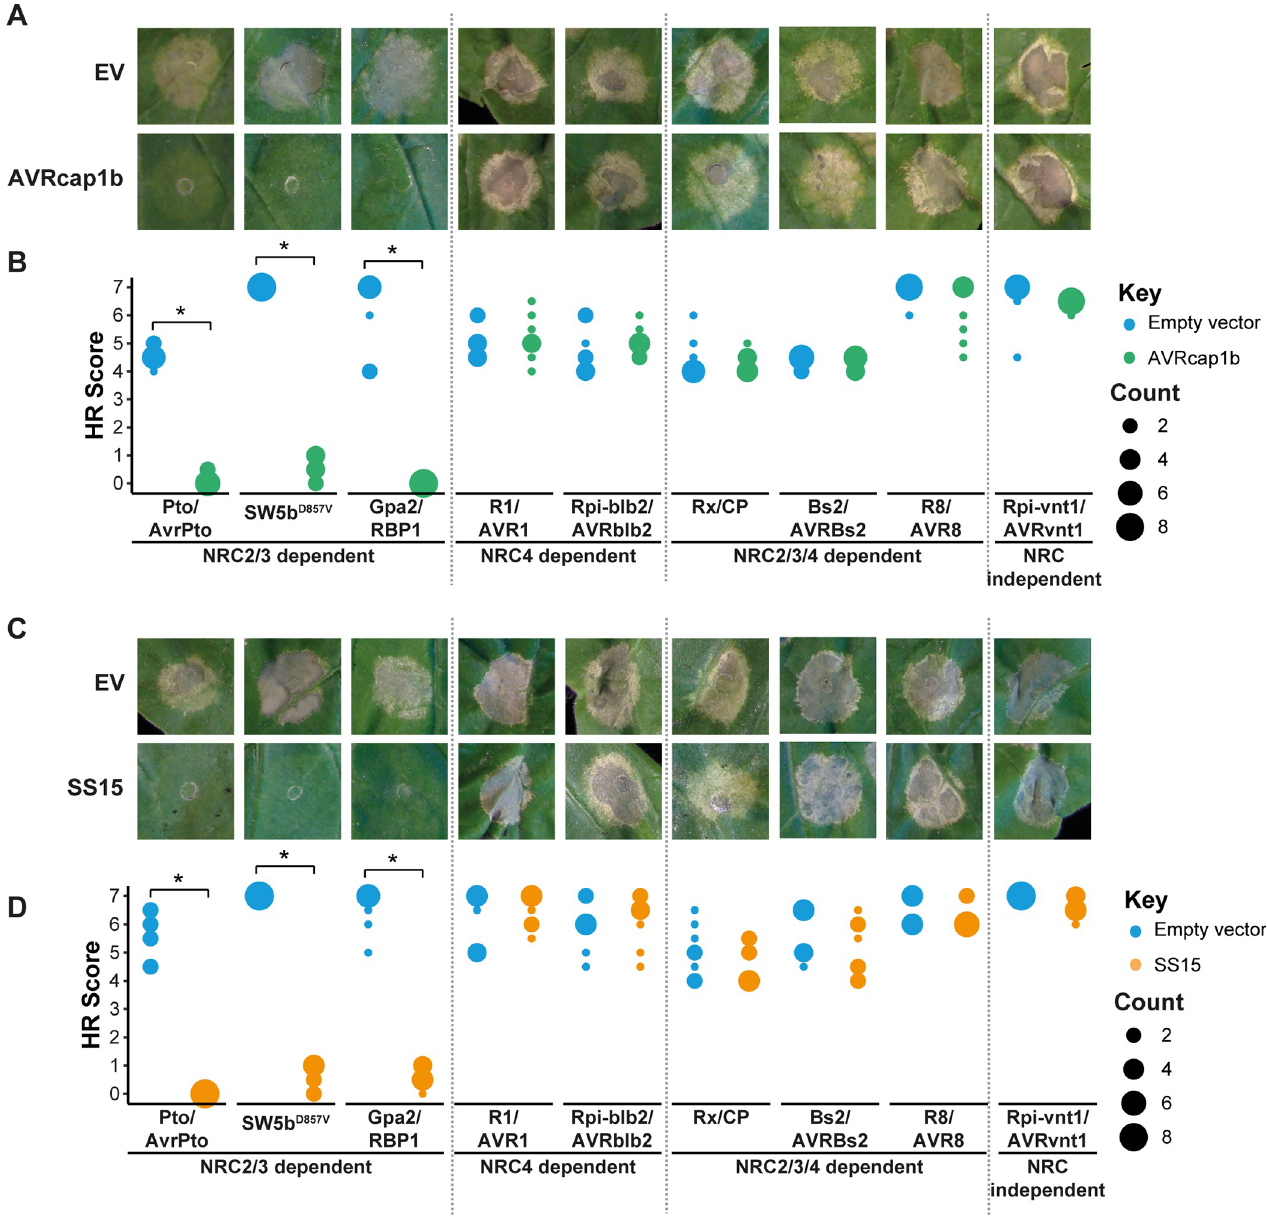
Fig 3. AVRcap1b and SS15 suppress cell death mediated by sensor NLRs that signal through NRC2 and NRC3 but not NRC4. Representative leaf panels showing HR phenotypes of (A) EV and AVRcap1b or (C) EV and SS15 coinfiltrated with a range of sensor NLRs (labelled on the bottom of panels B and D). Photographs were taken 5 days post-agroinfiltration. (B, D) HR results are presented as dot plots, where the size of each dot is proportional to the number of samples with the same score (count). A total of 8 technical replicates were completed for each treatment (S6 Data). Statistical tests were implemented using the besthr R library [41]. We performed bootstrap resampling tests using a lower significance cutoff of 0.025 and an upper cutoff of 0.975. Mean ranks of test samples falling outside of these cutoffs in the control samples bootstrap population were considered significant. Significant differences between the conditions are indicated with an asterisk ( � ). Details of statistical analysis are presented in S6 Fig. EV, empty vector; HR, hypersensitive response; NLR, nucleotide-binding domain and leucine-rich repeat; NRC, NLR required for cell